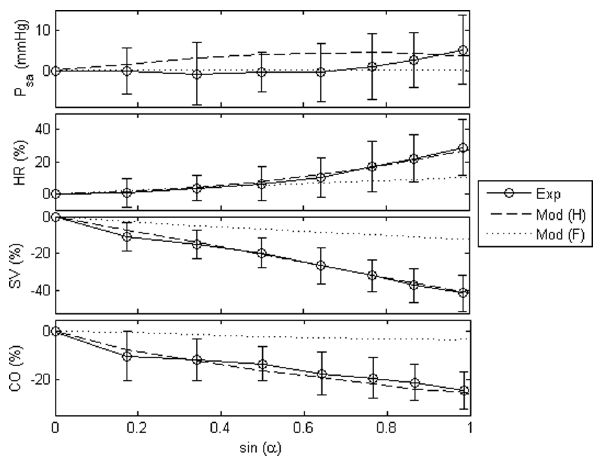
Figure 3. Changes in the mean arterial pressure ( P sa ), heart rate ( HR ), stroke volume ( SV ), and mean cardiac output ( CO ). Absolute value change in the mean arterial pressure ( P sa ), as well as percentage changes in the heart rate ( HR ), stroke volume ( SV ), and mean cardiac output ( CO ) at varying levels of tilt angles ( a ) for both healthy and heart failure conditions. Exp: experimental measurements; Mod (H): model simulation results under healthy condition; Mod (F): model simulation results under heart failure condition.